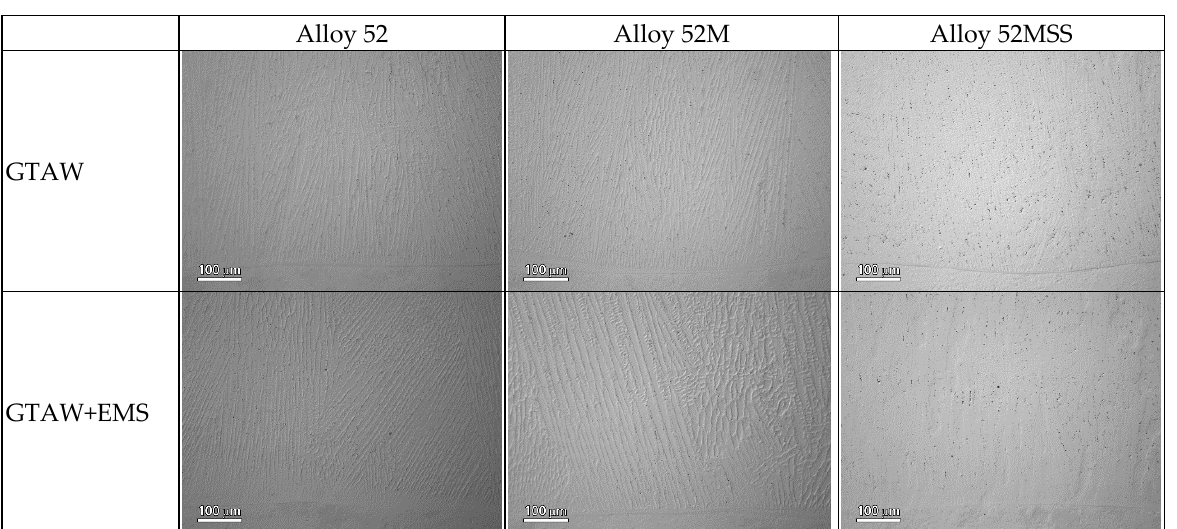
Figure 6. Micrographs of welds in the middle.